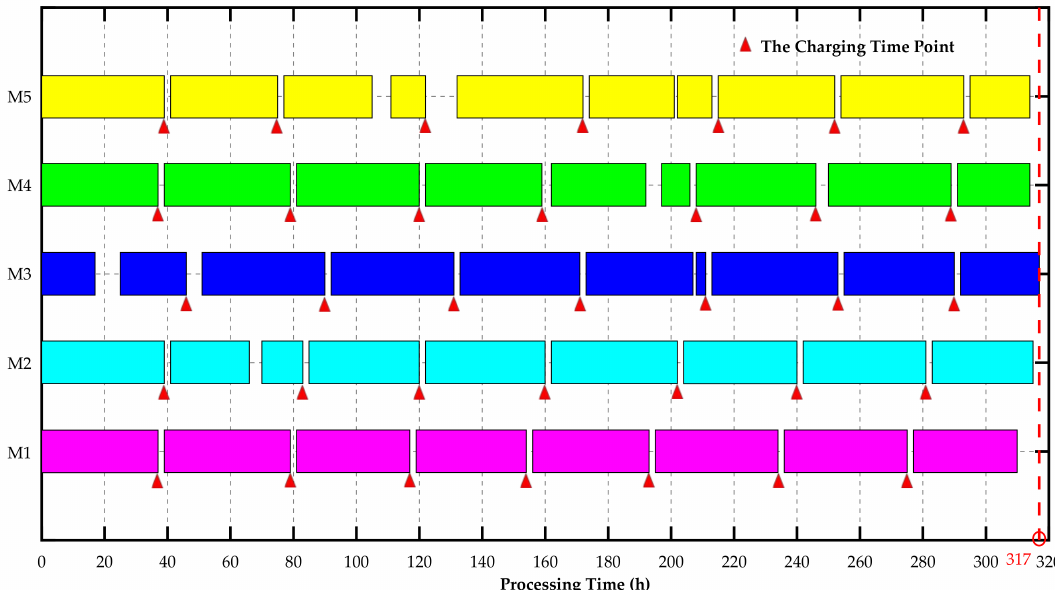
Figure 4. The time distribution of charging for wireless sensors and continuous processing for five machines based on the strategy of passively arranging charging time for wireless sensors with the associated machine having stopped